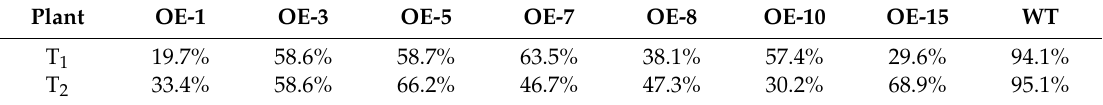
Table 1. The seed-setting rate of the TaICK1 over-expressing plants and wild-type plants. Plant OE-1 OE-3 OE-5 OE-7 OE-8 OE-10 OE-15 WT T 1 19.7% 58.6% 58.7% 63.5% 38.1% 57.4% 29.6% 94.1% T 2 33.4%